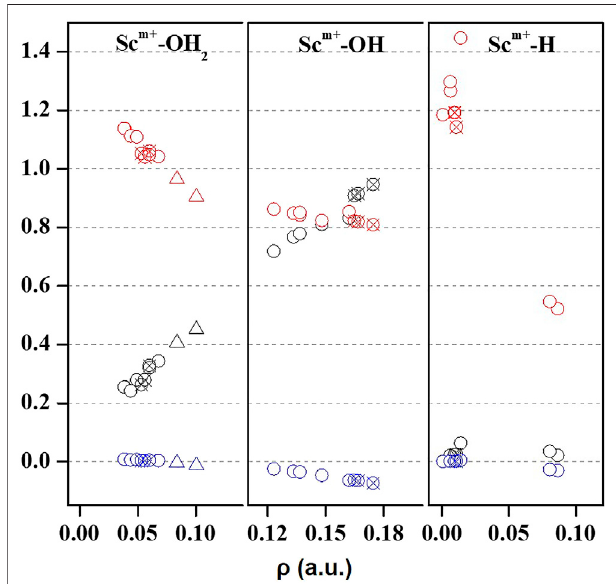
FIGURE 4 | Variation of Laplacian of electron density ( ∇ 2 ρ ; black), total energy density (H( r ); blue), and the ratio of kinetic energy density, that is, G( r ), and potential energy density ([ − G( r )/V( r )]; red) with respect to the electron density ( ρ ) obtained at BCP of Sc + – OH 2 , Sc + – OH, and Sc + – H bonds of mono- (circle), di- (cross circle), and tricationic (triangle) water and its insertion